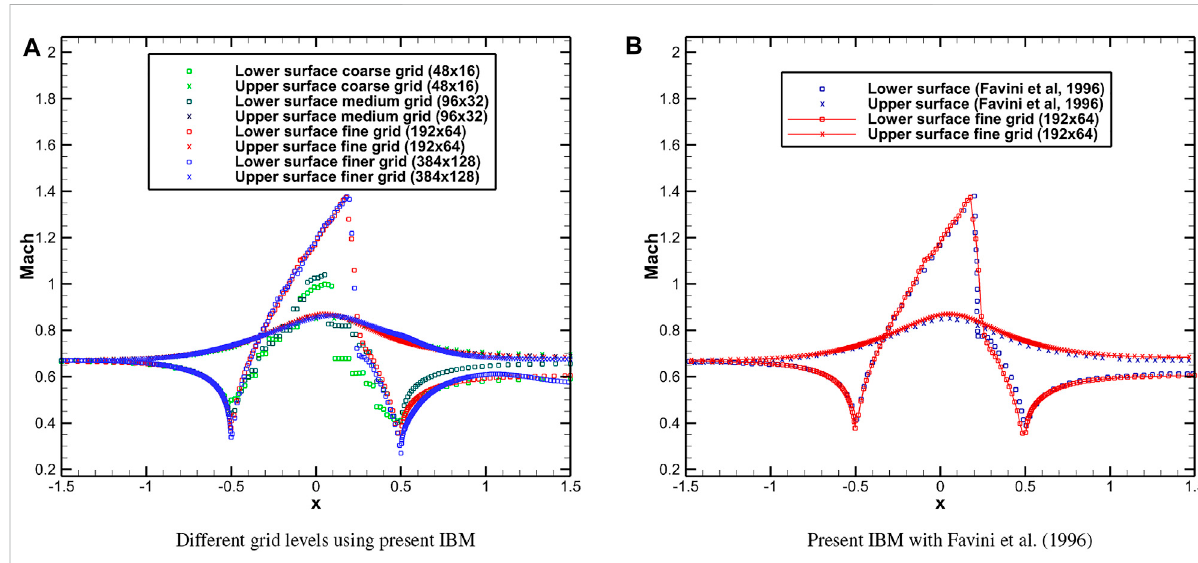
FIGURE 10 Mach number distribution on the upper and lower walls for transonic fl ow over a bump. (A) Different grid levels using present IBM. (B) Present IBM with Favini et al. (1996).